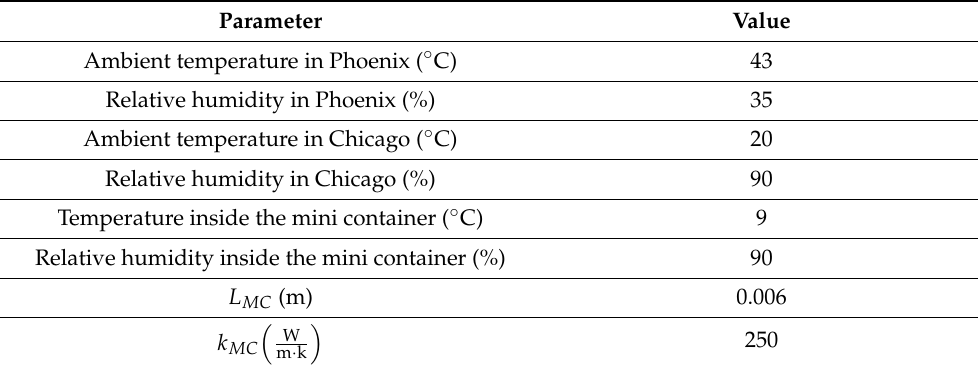
Table 1. All relevant parameters used in the